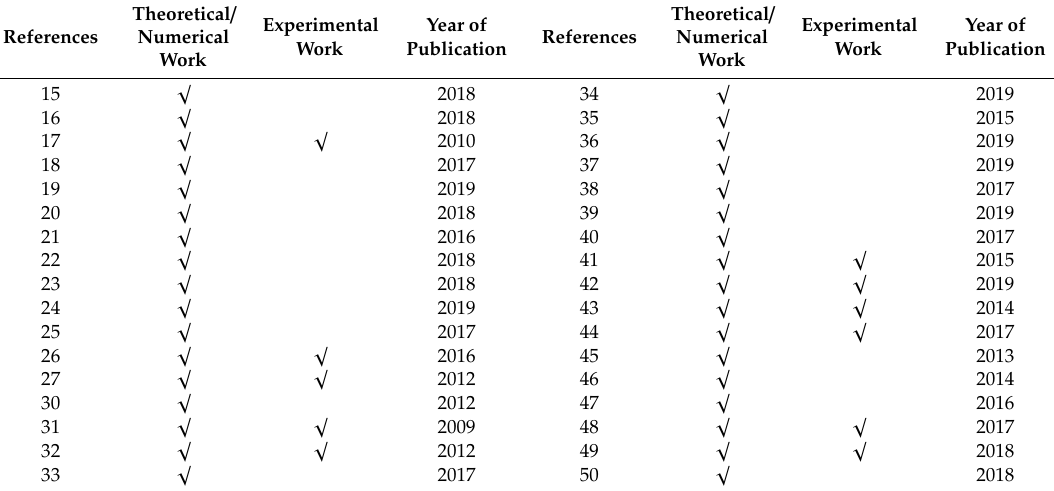
Table A1. The nature of the work for some